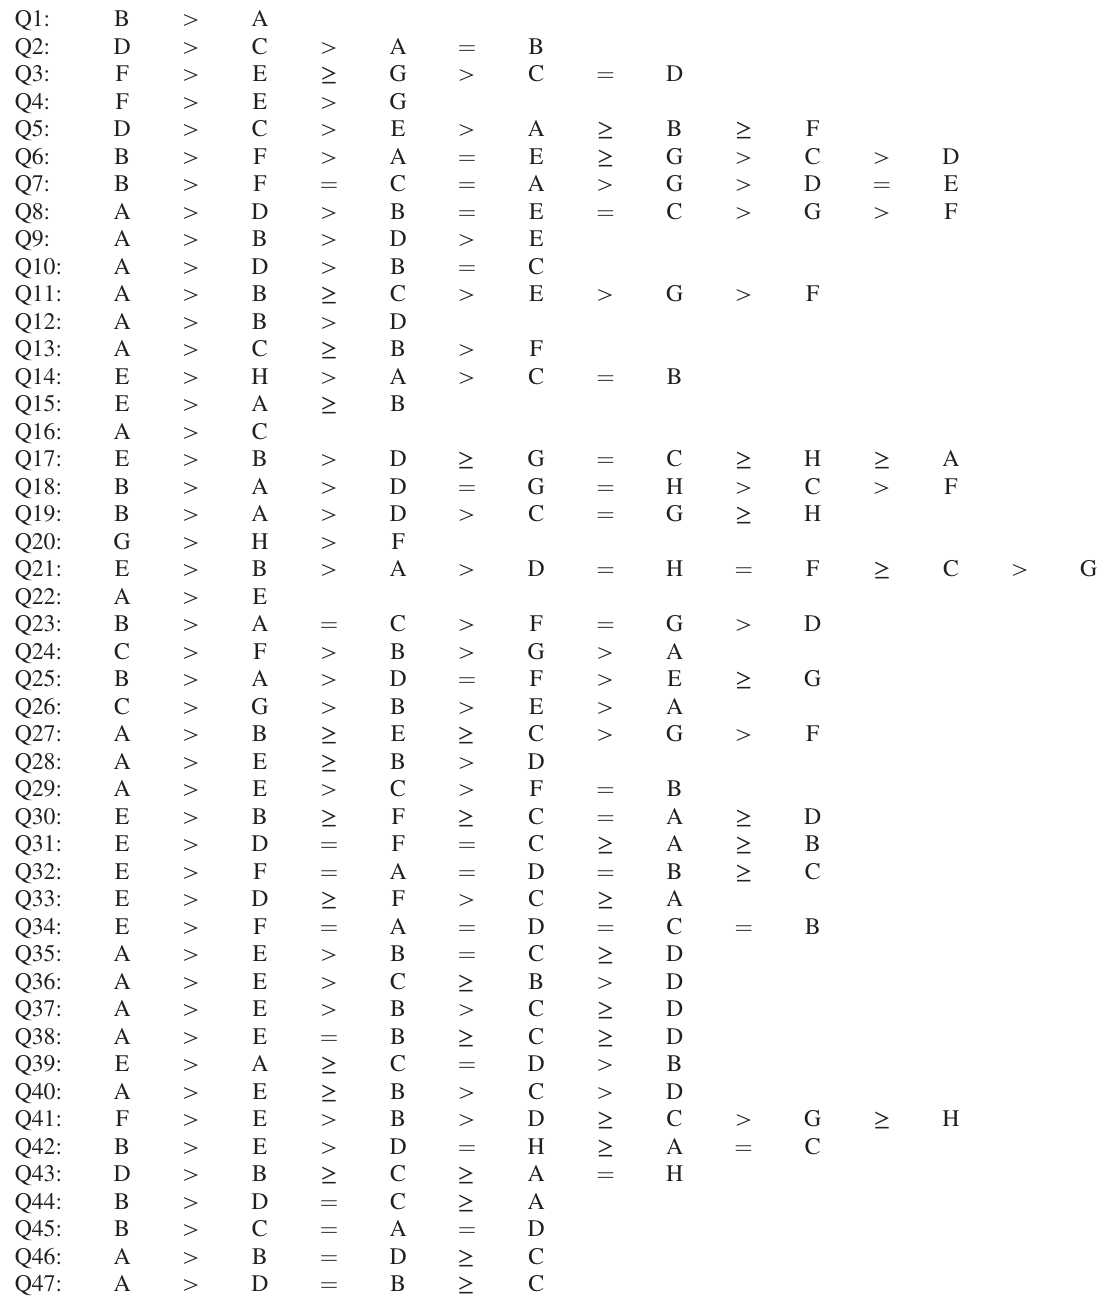
TABLE III. IRT ranking results: filtered so that only responses given by at least 1% of the population are